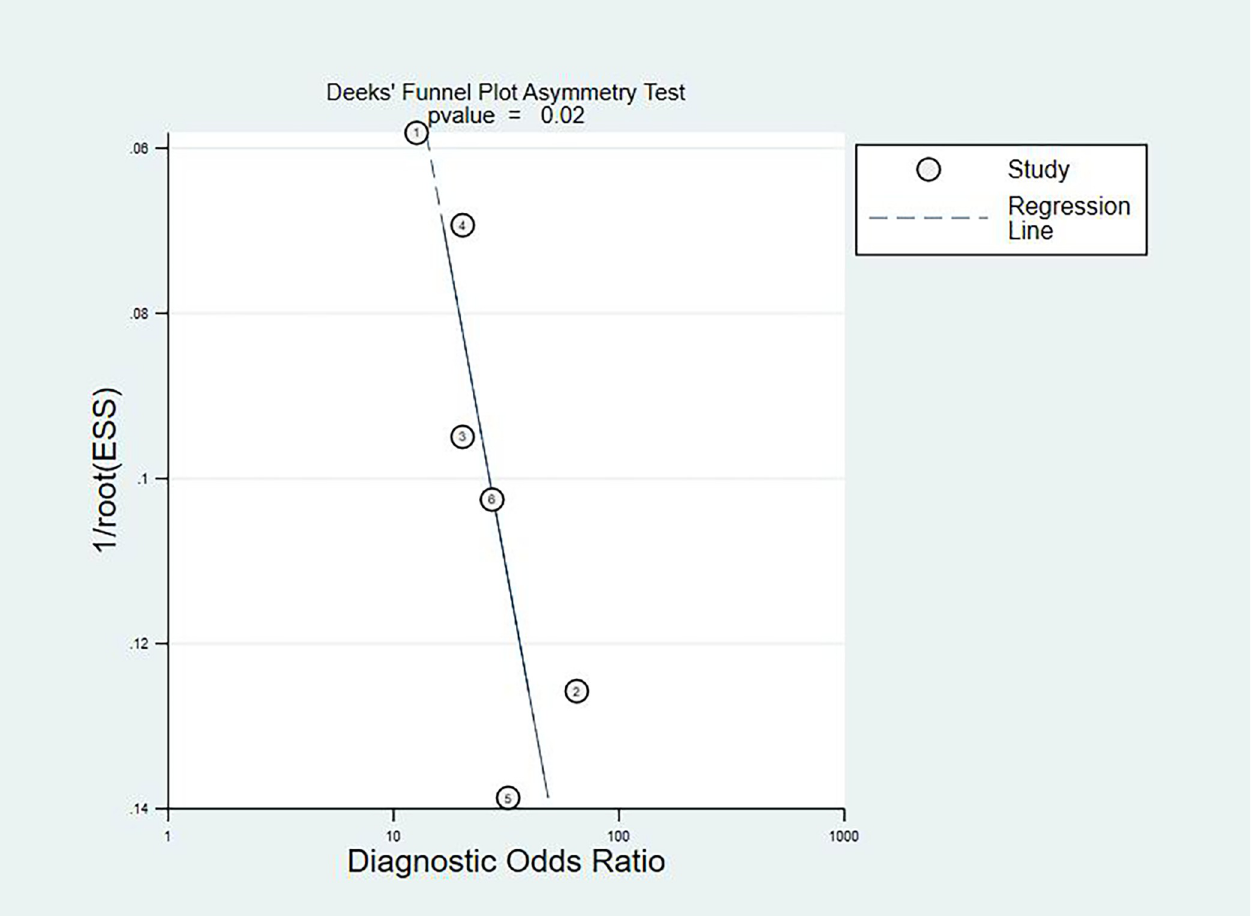
Fig 6. Begger’s funnel plot of publication bias on the pooled OR. No publication bias was detected in this meta-analysis.